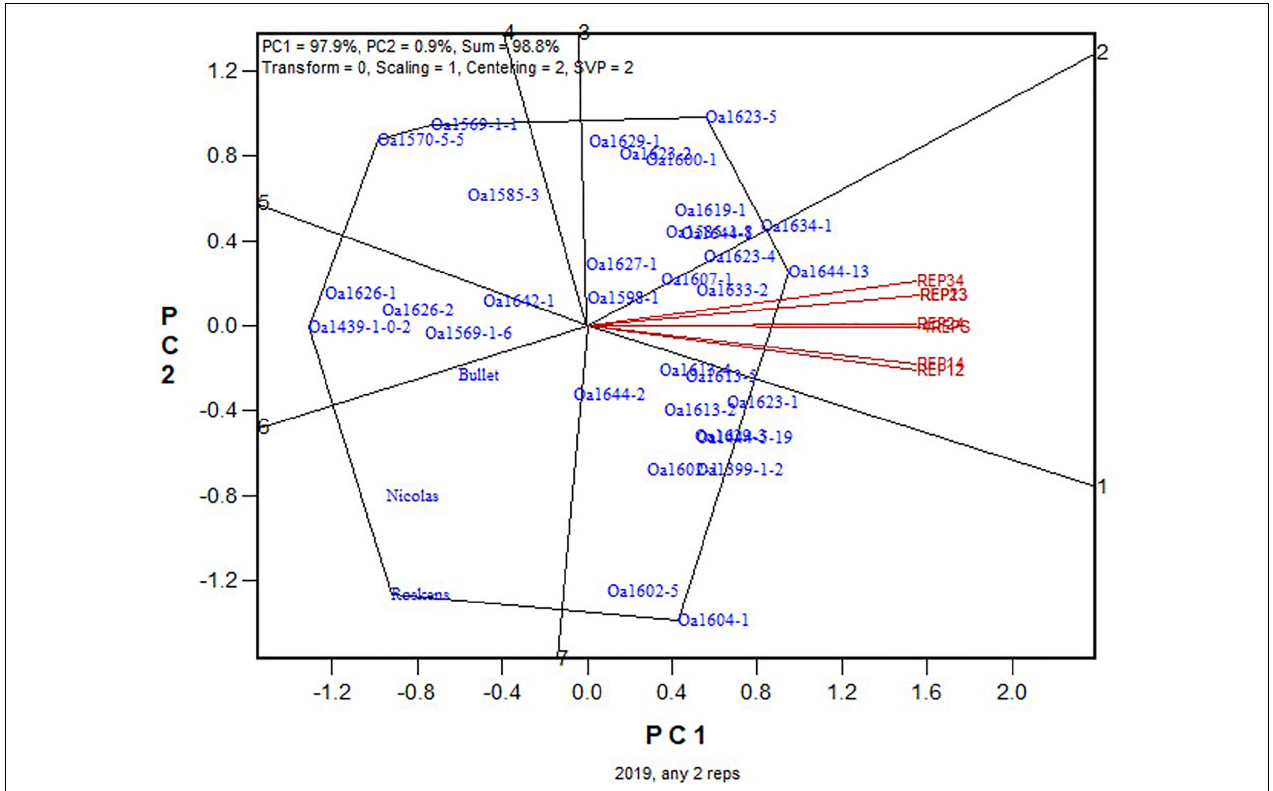
FIGURE 3 | Summary biplot for the 2019 Ontario trials to show the similarity/dissimilarity between genotypic rankings based on any 2-rep combinations and that based on all four replicates. 4REPS, genotypic ranking based on all four replicates; REP12, genotypic ranking based on replicates 1 and 2; REP13, genotypic ranking based on replicates 1 and 3, and so